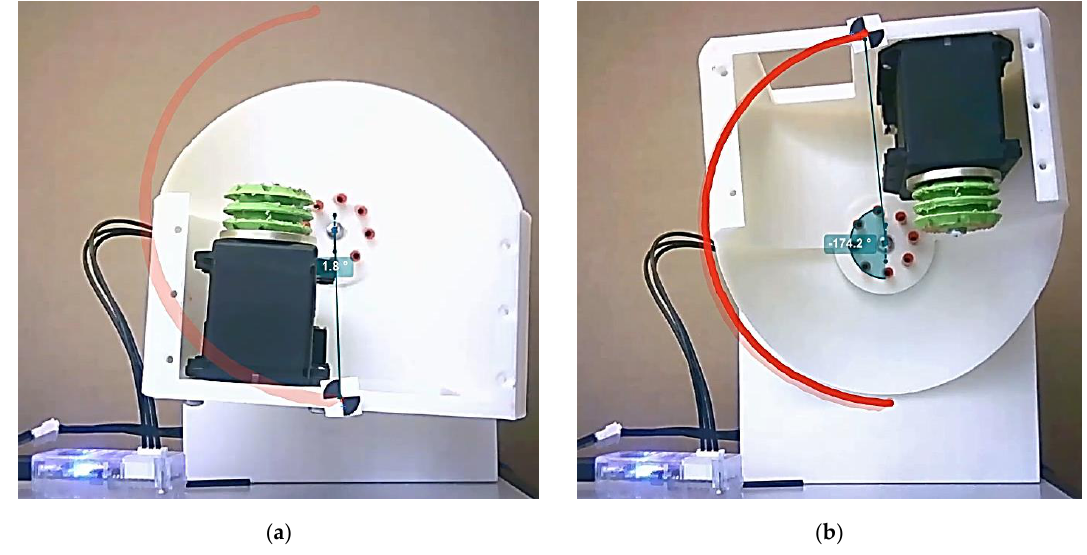
Figure 13. Motor unit experimental test: ( a ) Starting position, ( b ) Final position.